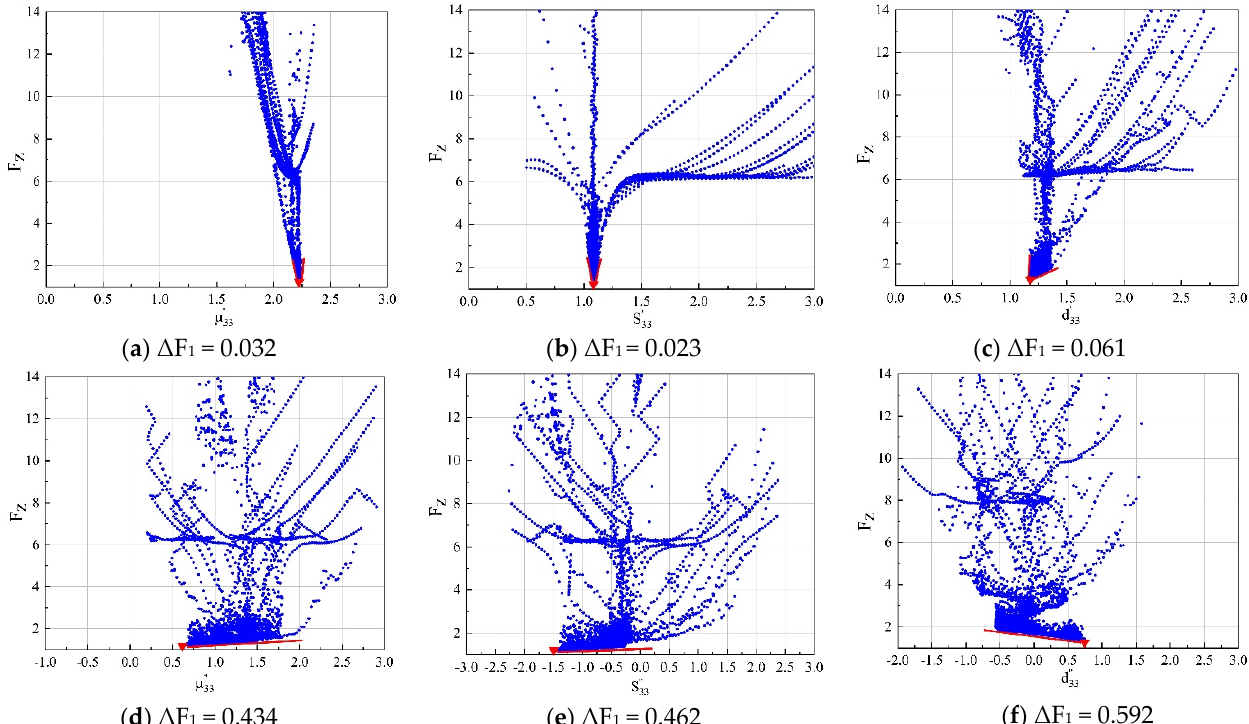
Figure 11. Sensitivities of six parameters in Method 1. Δ F 1 is used to quantify the global sensitivity, which has been defined.